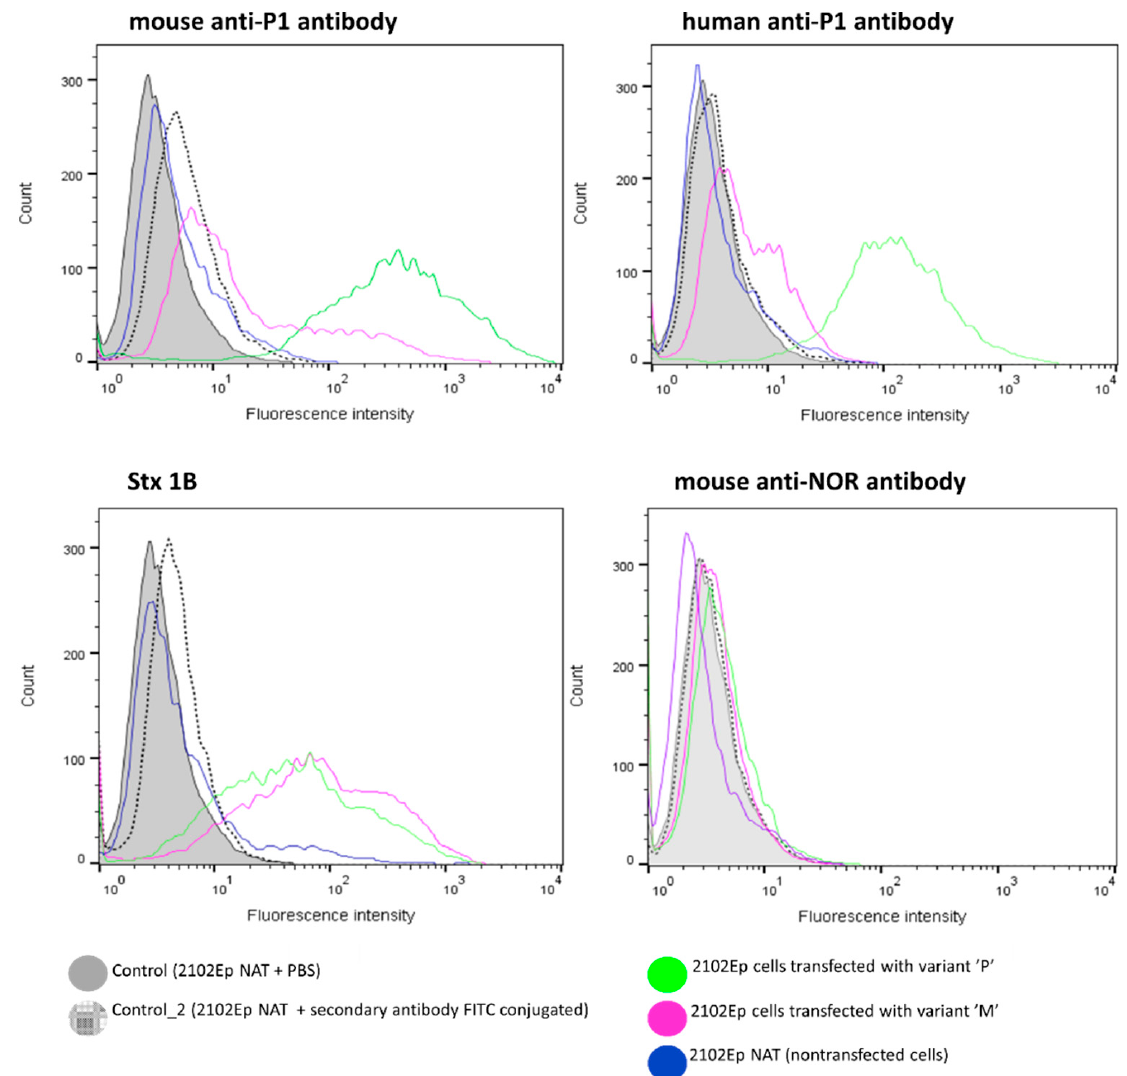
Figure 1. Flow cytofluorometry analysis of 2102Ep cells transfected with the vectors encoding M and P enzymes using mouse anti-P1 antibody (specificity: P1 and Gb3), human anti-P1 antibody (specificity: P1), mouse anti-NOR antibody and Stx1B; NAT: nontransfected 2102Ep cells used as a negative control.